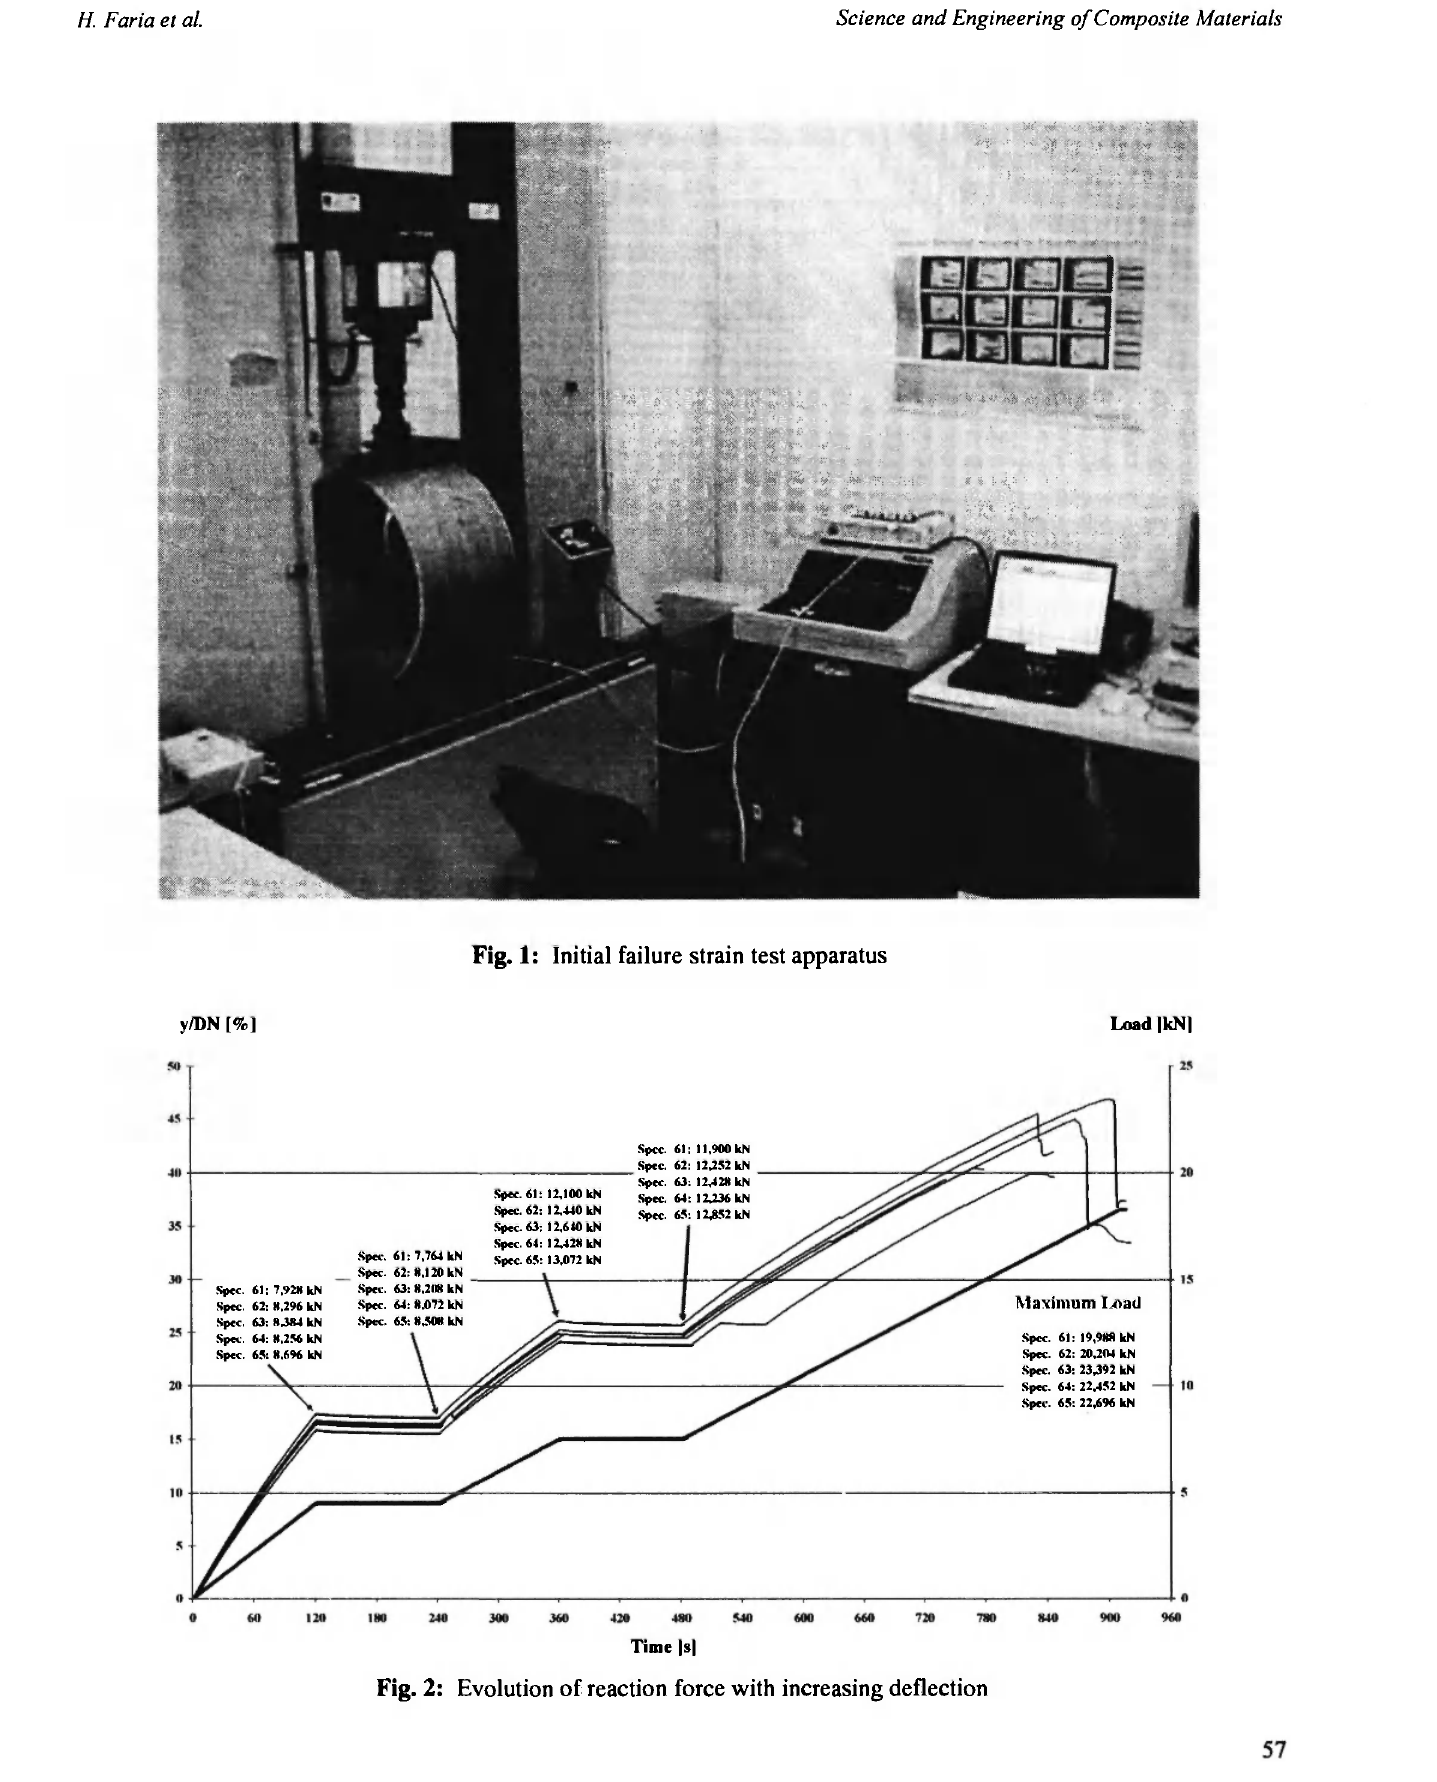
Fig. 2: Evolution of reaction force with increasing